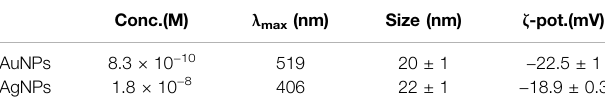
TABLE 1 | Physicochemical properties of NPs obtained by UV-Vis, SAXS, and ζ -potential measurements. The reported concentration values correspond to the concentration of NPs in the aqueous dispersion, obtained from the synthesis. Beforeeachmeasurement,AgNPsconcentrationhasbeenadjustedbydilution,to match the one of AuNPs (8.3 × 10 − 10